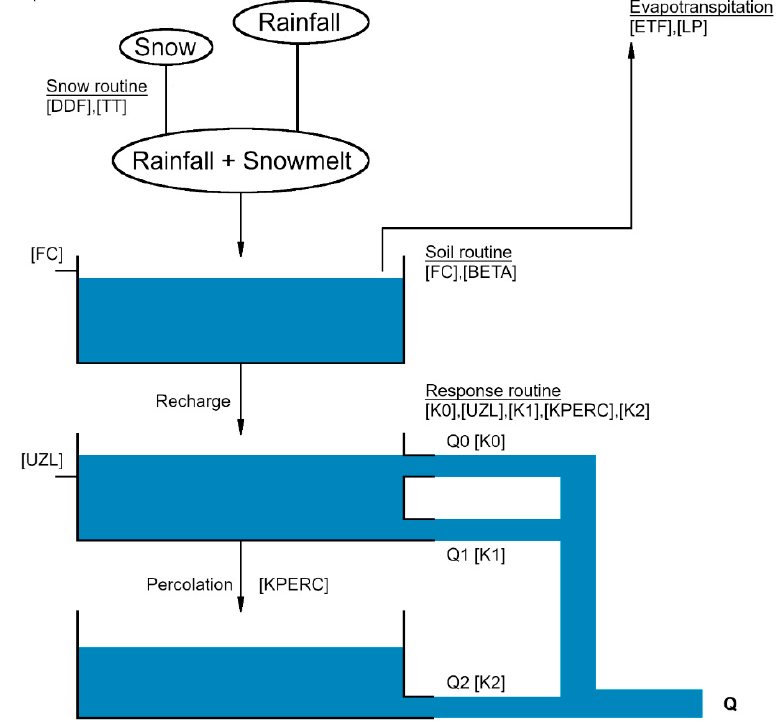
Figure 2. HBV (Hydrologiska Byråns Vattenbalansavedelning) model structure (inspired by Bergström [38]). The model parameters are enclosed in square brackets.